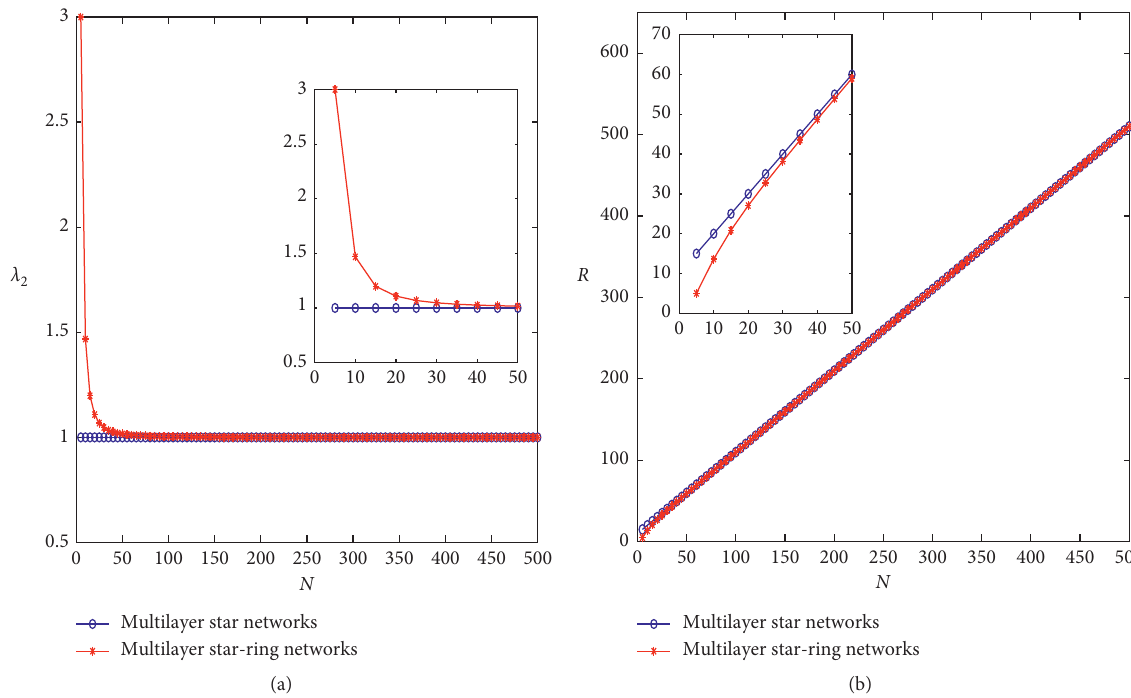
Figure 16: The synchronizability of multilayer star and star-ring networks, where a � 1, d � 1, M � 10, and a < Md . (a) λ varying N for multilayer star and star-ring networks. (b) R with respect to varying N for multilayer star and star-ring